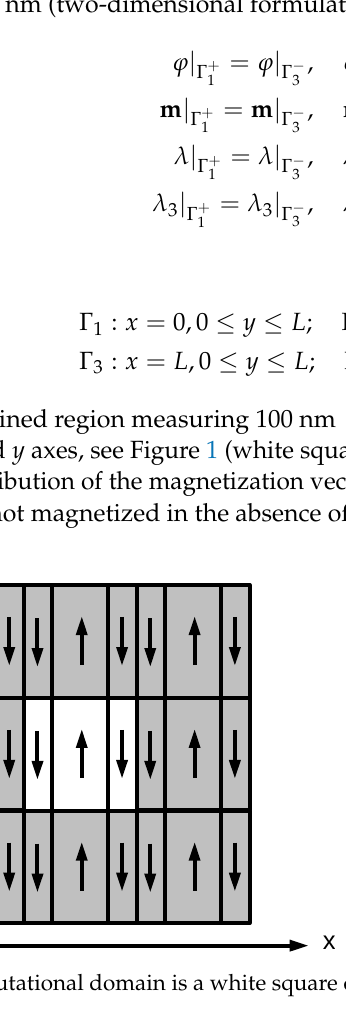
10 5 A/m, magnetocrystalline × 10 5 J/m 3 [8,16], and the exchange constant is A exch = ×